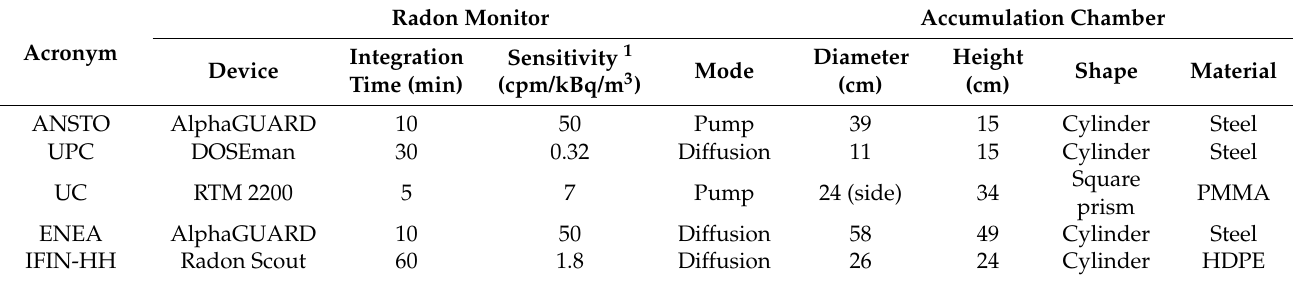
Table 2. Device features used by every